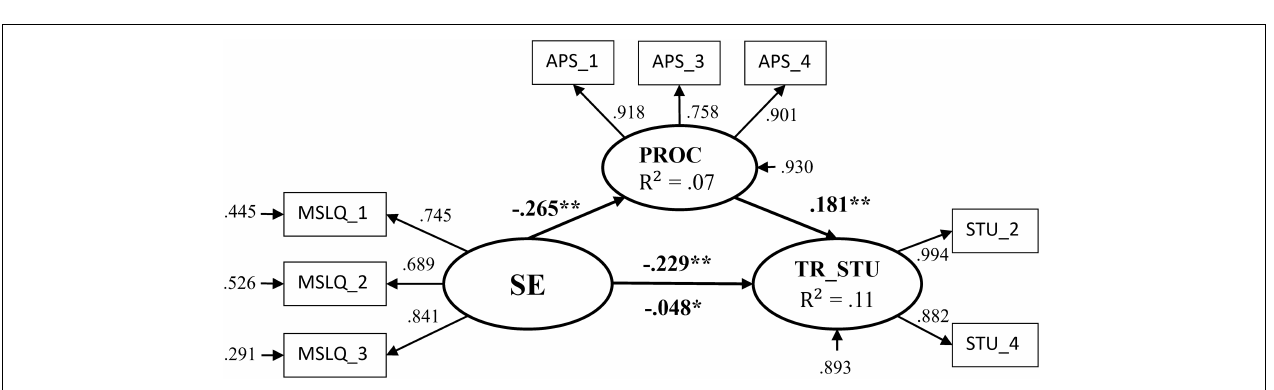
FIGURE 3 | Mediation model for transfer study field intentions ( n = 693). Indirect effect is provided below the path line. SE, academic self-efficacy; PROC, procrastination; TR_STU, transfer study field intentions. * p ≤ 0.01, ** p ≤